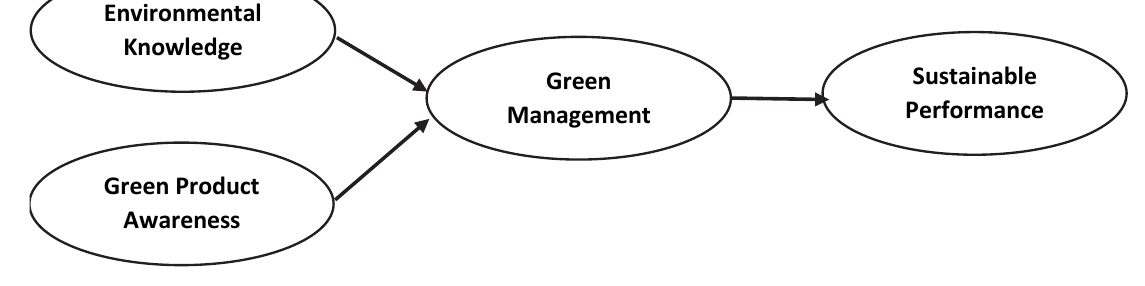
Fig. 1. Research Theoretical